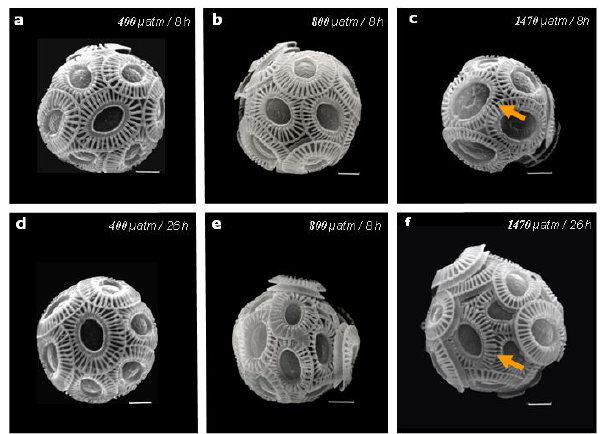
Fig. 3. Scanning electron microscope pictures of Emiliania hux- leyi grown under different CO 2 concentrations after 8h of exposure to (a) 410µatm, (b and e) 800µatm and (c) 1500µatm, and after 26h of exposure to (d) 410µatm and (f) 1500µatm. The photos chosen are representative of the trend observed. Note the presence of under-calcified coccoliths under enhanced CO 2 conditions, es- pecially visible in the connections between the elements forming the “outer ring” (orange arrows) and in the frequent enlargement of the central area. For the 800µatm treatment both photographs correspond to cells exposed to the increase on CO 2 concentrations for 8h, because no differences were found within the time consid- ered (8 and 26h) and the photographs taken after 26h were not well focused. Scale bars correspond to 1µm.